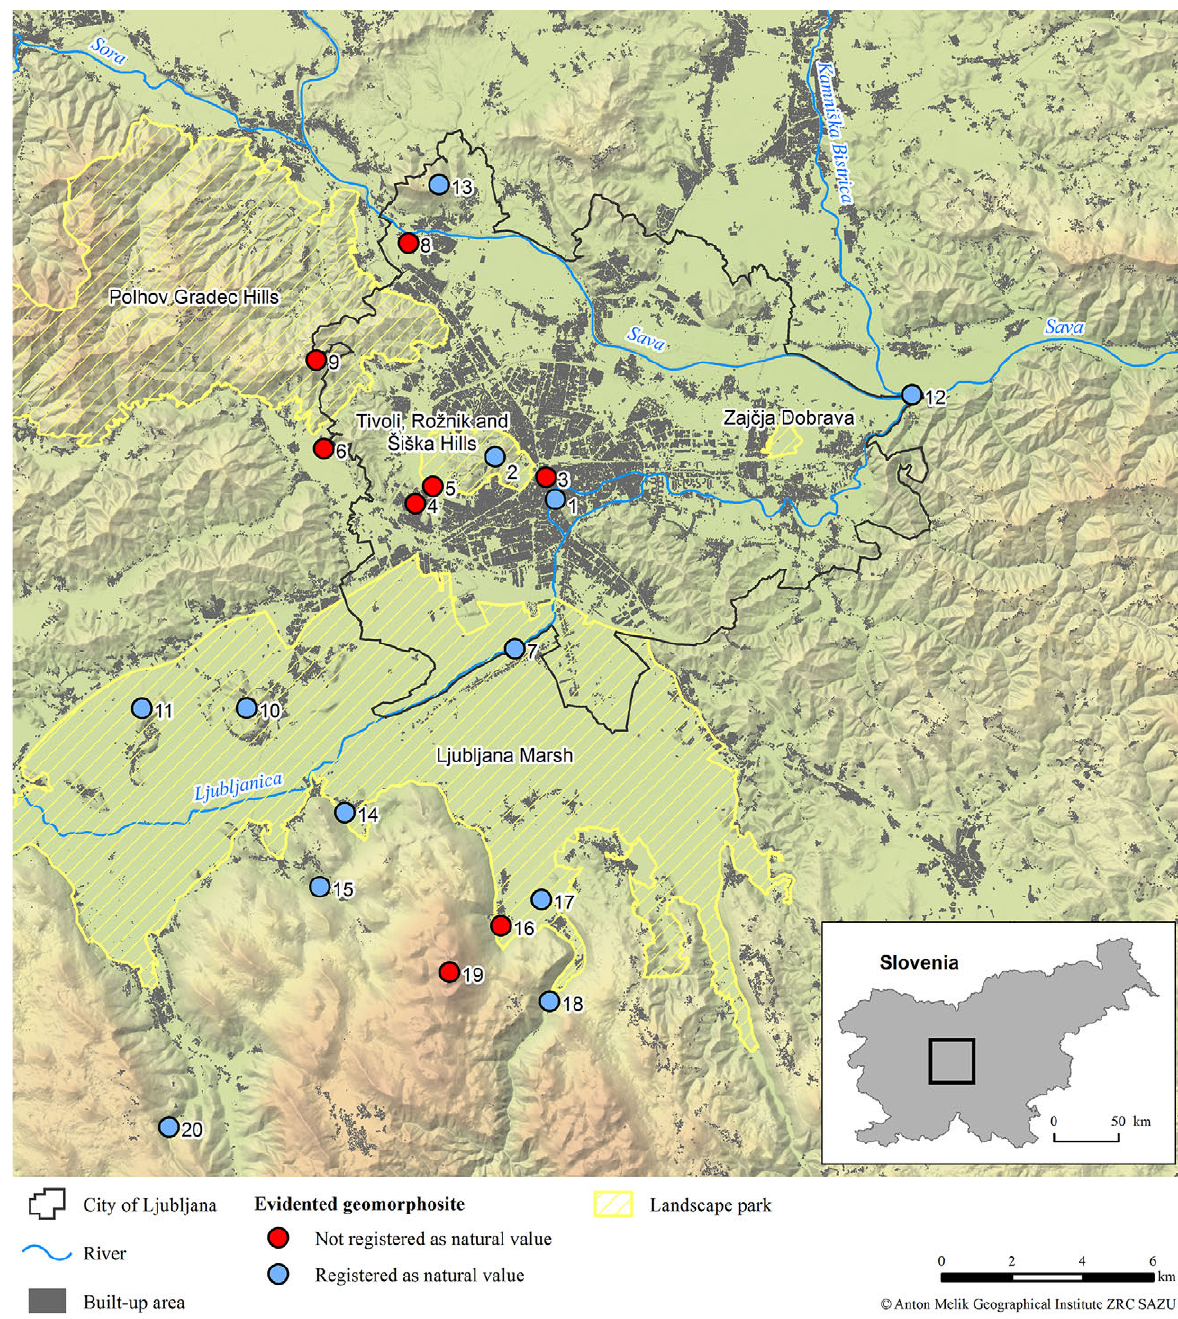
Fig. 7. Map of geoheritage sites from Table